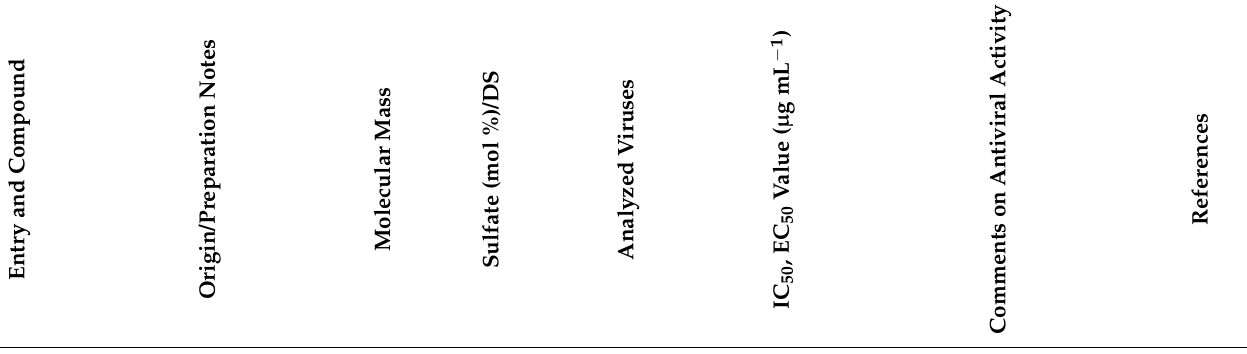
Table 2. Sulfated polysaccharides obtained by chemical sulfation reaction on isolated material: molecular weights, sulfate contents (mol %) and their half-maximal inhibitory in vitro /effective concentrations (IC 50 , EC 50 ) referring to the indicated viruses.